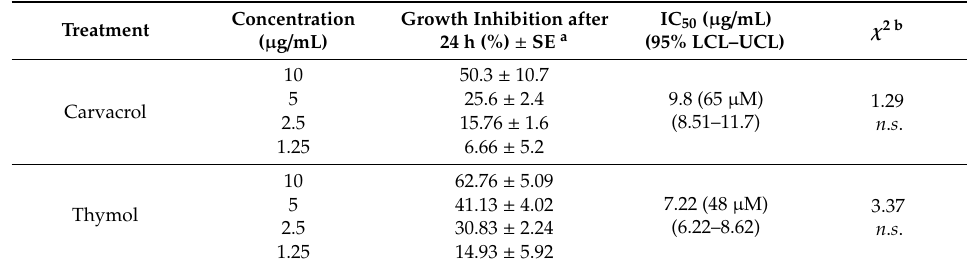
Table 1. Probit analysis showing the e ffi cacy of carvacrol and thymol against Leishmania infantum